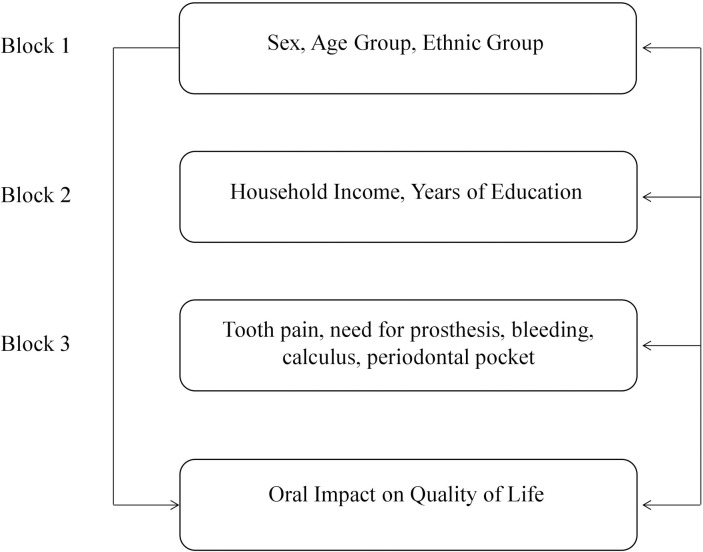
Conceptual model to study the association between independent variables and oral impact on daily performance (adapted from Peres et al., 2013 [1]).